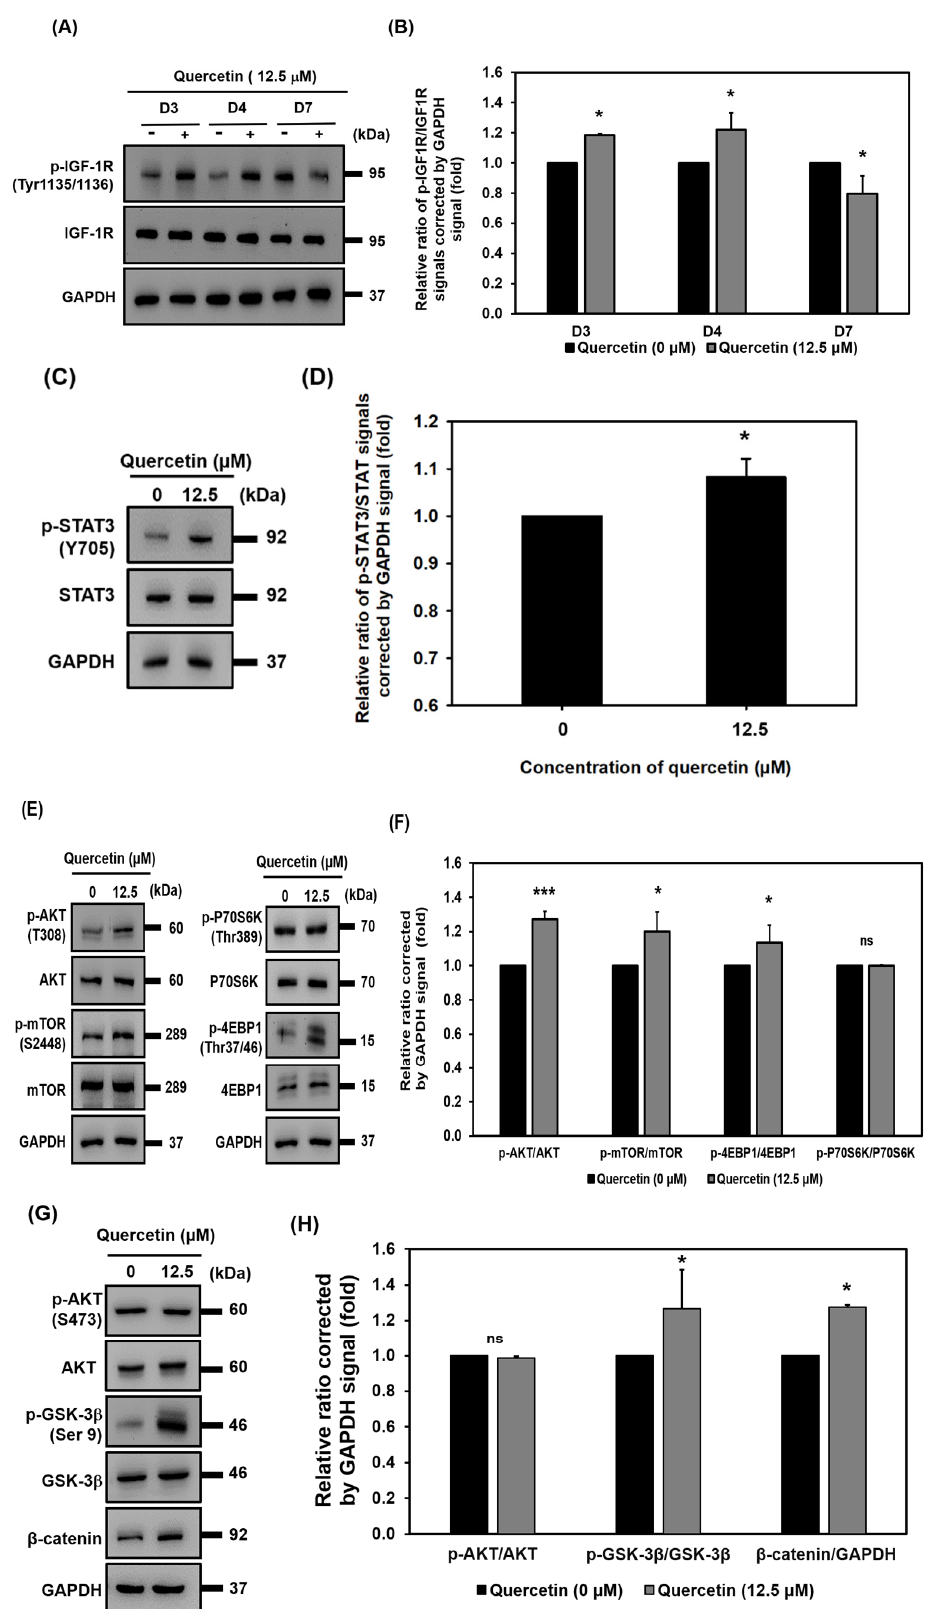
Figure 7 . Quercetin induced early upregulation of IGF-1R and promoted myogenic differentiation and protein synthesis downstream via the IGF-1R signaling pathway. C2C12 cells were grown to 80% confluency density in a 24-well plate. The cells were untreated or treated with quercetin (0, 12.5 μ M) and cultured in DMEM medium containing 2% horse serum to promote cell differentiation for 7 days. Western blot analysis was used to study the expression of proteins related to IGF-1R and AKT signaling, with GAPDH used as internal control. ( A ) Western blot images of phosphorylated IGF-1R and IGF-1R. ( B ) Bar graphs show quantified relative protein expressions. ( C ) Western blot shows analysis of protein expression of p-STAT3 and STAT3. ( D ) Bar graphs show quantified rela- tive expressions. ( E , F ) Western blot images and quantification level protein related to the AKT/mTOR signaling pathway. ( G , H ) Western blot images and quantification level protein related to AKT/GSK-3 β / β -catenin. Data are expressed as mean ± SD based on three independent biological repeats ( n = 3), * p < 0.05, *** p < 0.001 indicate a significant difference between the control group and quercetin-treated group. (ns: not significant) 3.8. AKT Activation Is Required for Induction of Myogenic Differentiation by Quercetin Because we found that quercetin increased the expression of phosphorylated AKT (T308) and activated the phosphorylation of mTOR and 4EBP1 to promote myogenic dif- ferentiation, we wanted to determine whether AKT was necessary for quercetin to exert its effect on myogenic differentiation. To achieve this, we incubated C2C12 cells with a specific AKT inhibitor (LY294002) for 7 days. As can be seen in Figure 8, blocking AKT lead to a decrease in expression of MHC and an inhibition of myogenic differentiation regardless of whether quercetin was present or not. Meanwhile, treatment with quercetin increased the protein expression of p-AKT (T308) and p-4EBP1(Thr37/46) in the cells pre- treated with the blocker LY294002 (Figure 8). Phosphorylation of the AKT (T308) consen- sus target was the first proposed phosphorylation of mTOR at S2448 [23,24]. However, pretreatment with LY294002 did not inhibit the phosphorylation of mTOR(S2448) (Figure 8), leaving us to infer that quercetin induced myogenic differentiation through the AKT/4EBP1 signaling pathway .